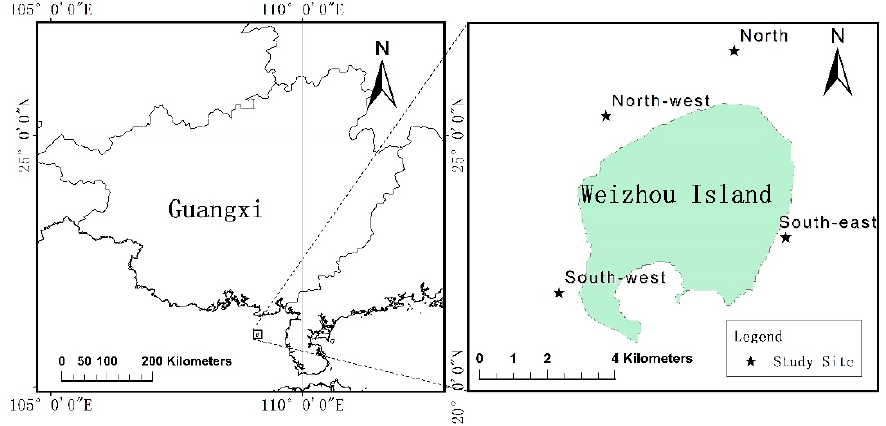
Figure 1. Position of Weizhou Island and the study sites.